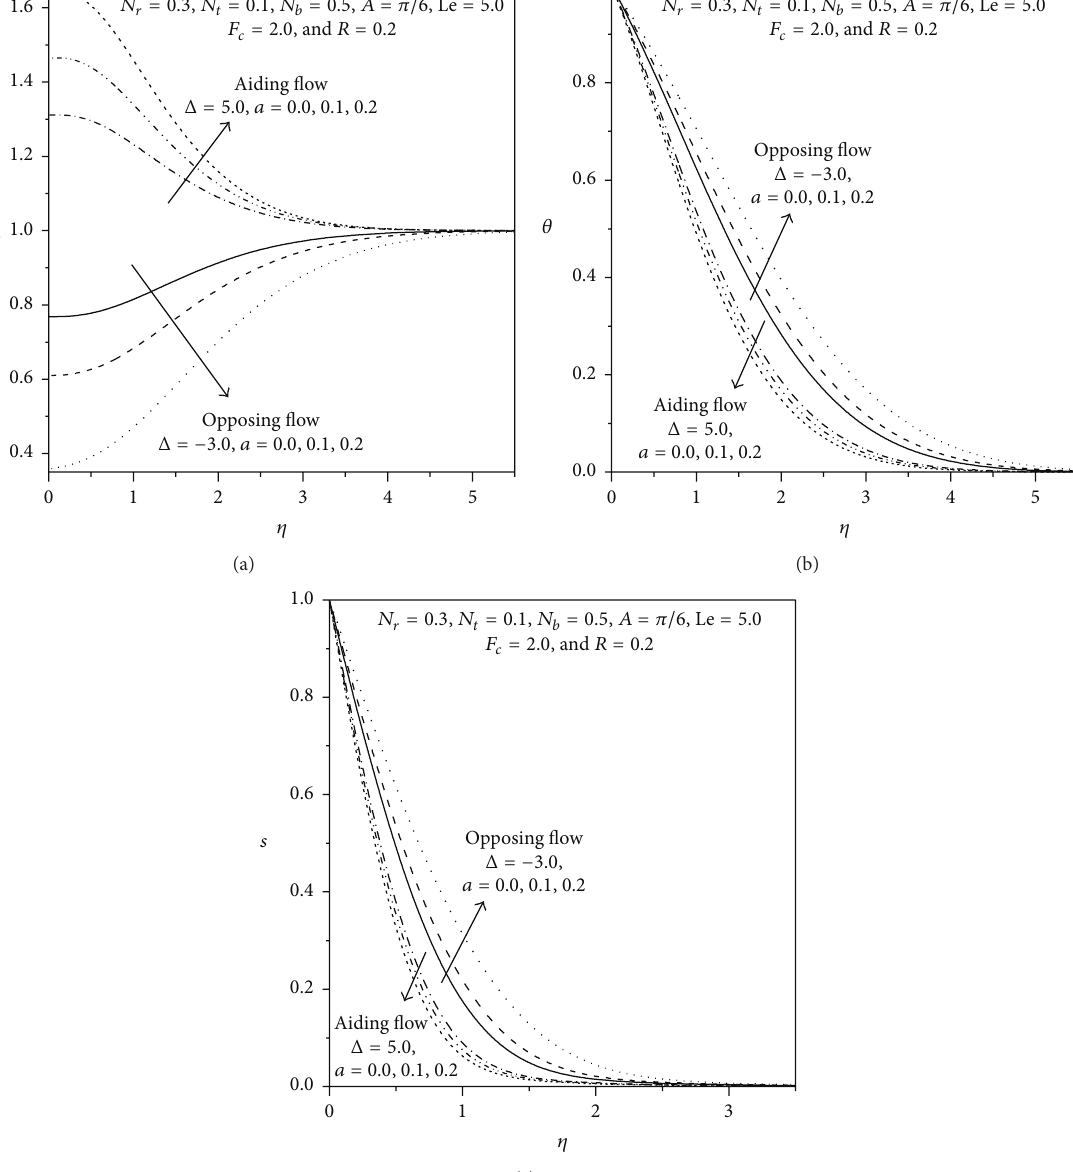
heat and nanoparticle mass transfer rates are computed and presented graphically in Figures 2–11. The effects of radiation 𝑅 , angle of inclination 𝐴 , Brownian motion parameter 𝑁 thermophoretic parameter 𝑁 𝑡 , non-Darcy parameter 𝐹 𝑐 , and amplitude 𝑎 of the wavy surface have been discussed. Figure 2 shows the effect of the amplitude of the wavy surface on velocity, temperature, and nanoparticle volume fraction distributions. It is observed that as 𝑎 increases, velocity increases near the plate and decreases away from the plate, whereas the temperature and nanoparticle volume fraction decrease for aiding flow and the reverse trend is observed in the case of opposing